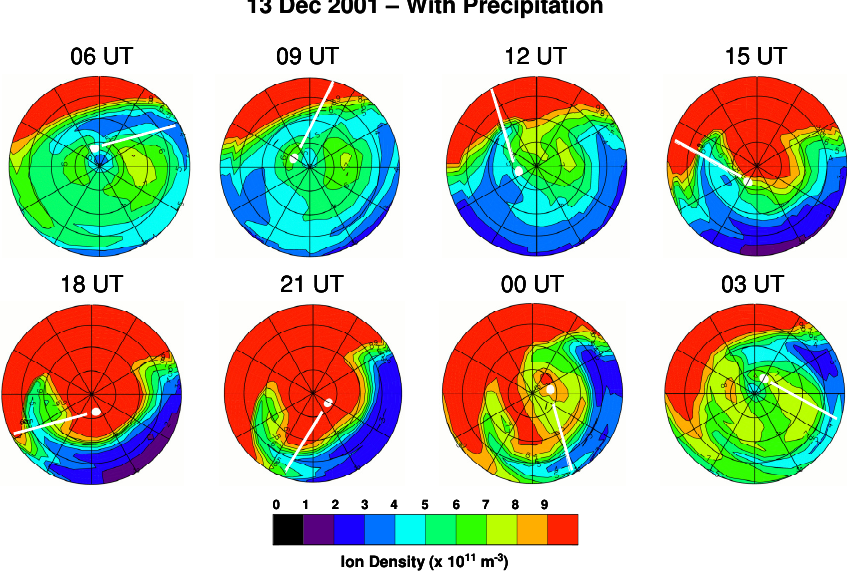
Fig. 7. Ion densities modelled by CTIP for 13 December 2001, but with precipitation input included in the model. The panels are at 3-h intervals of UT, with each panel showing the ion density distribution at an altitude of 320km, near the nightside F-region ionisation peak, as a function of MLAT and MLT. The format of the panels is as for Fig. 4, with the white line showing the 18 ◦ E meridian near the longitude of the Scandinavian tomography chain.